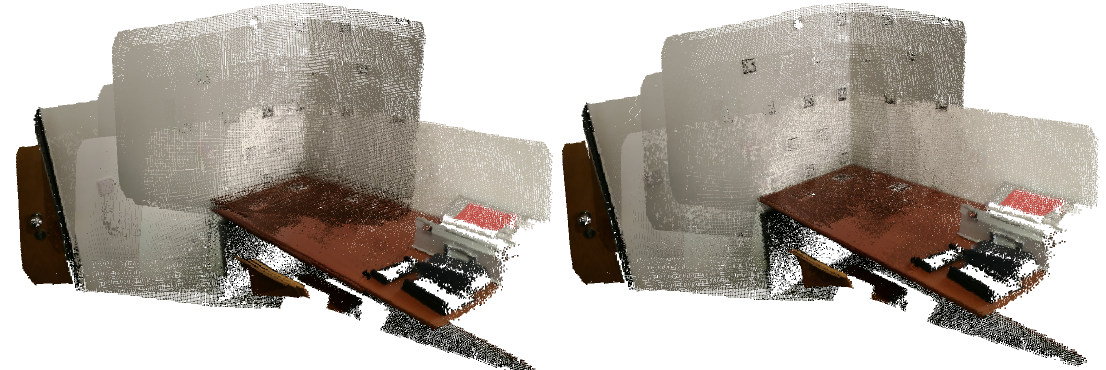
Figure 16. Point cloud coloured with texture obtained from restored images, no cross-inpainting: ( left ) before optimization; ( right ) after